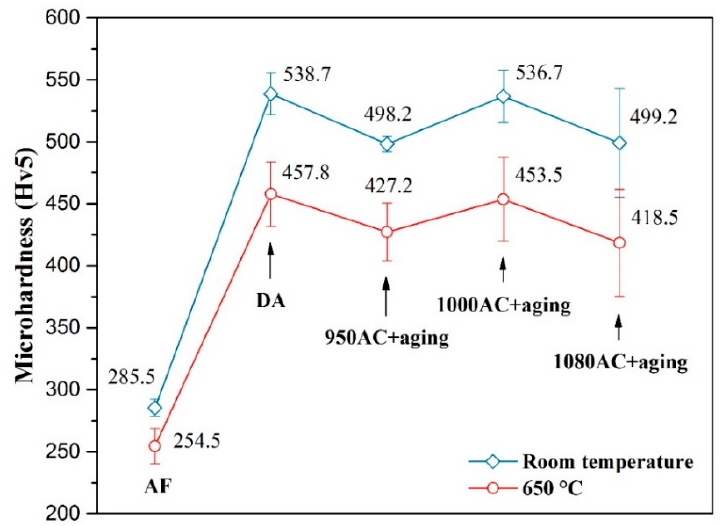
Figure 8. Vickers hardness of the SPS IN718 alloys at room temperature and 650 ° C.